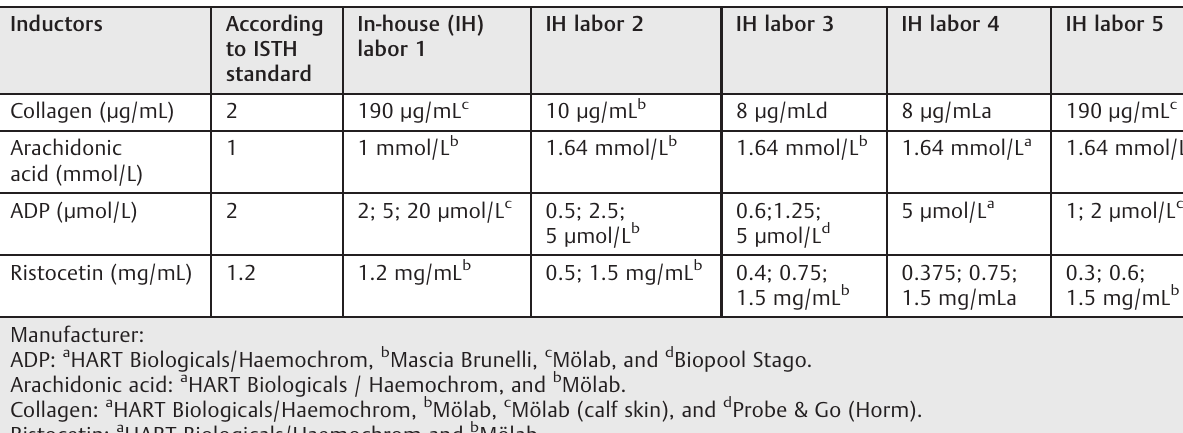
Table 3 Inductor fi nal concentrations and manufacturers for methods A to C Inductors According to ISTH